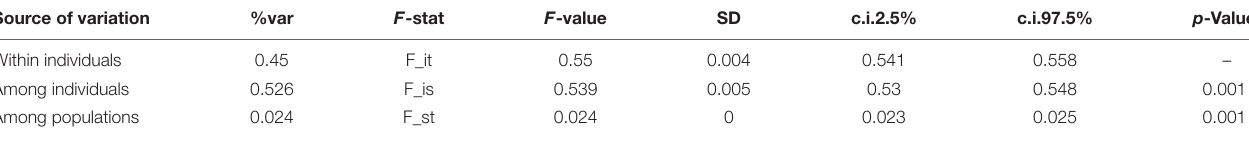
TABLE 3 | Proportion of variation based on AMOVA results from 17,828 SNP markers. Source of variation